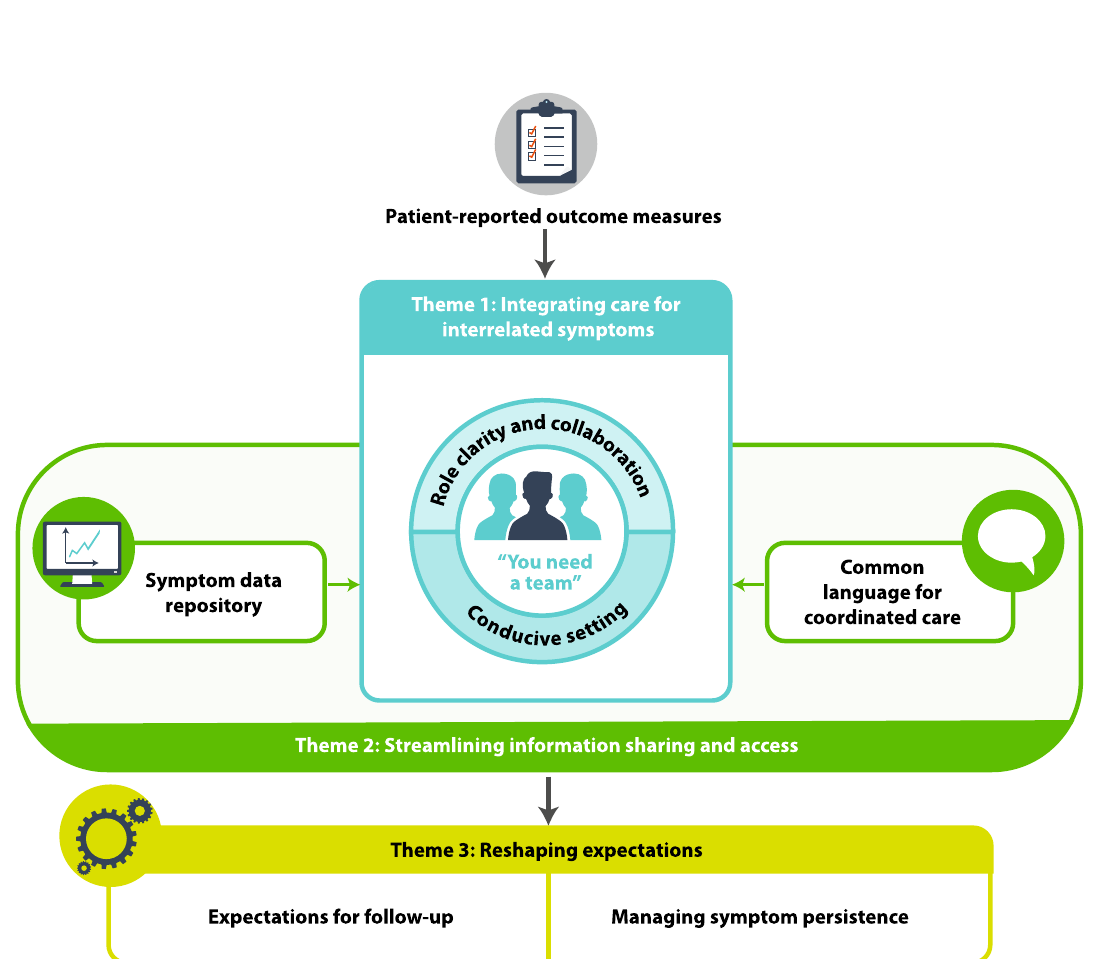
Fig. 1 Relationship between thematic findings. PROM use supported an interdisciplinary approach to symptom management within the hemodialysis unit by highlighting the interrelatedness of symptoms and helping define team members’ roles and responsibilities to address patients’ evolving needs (Theme 1, blue ). PROM use established a symptom data repository and streamlined communication channels that influenced interprofessional and patient‑provider interactions (Theme 2, green ). When symptoms persisted, PROMs prompted broader conversations between patients and their care team about illness perception and realistic goal setting (Theme 3, yellow